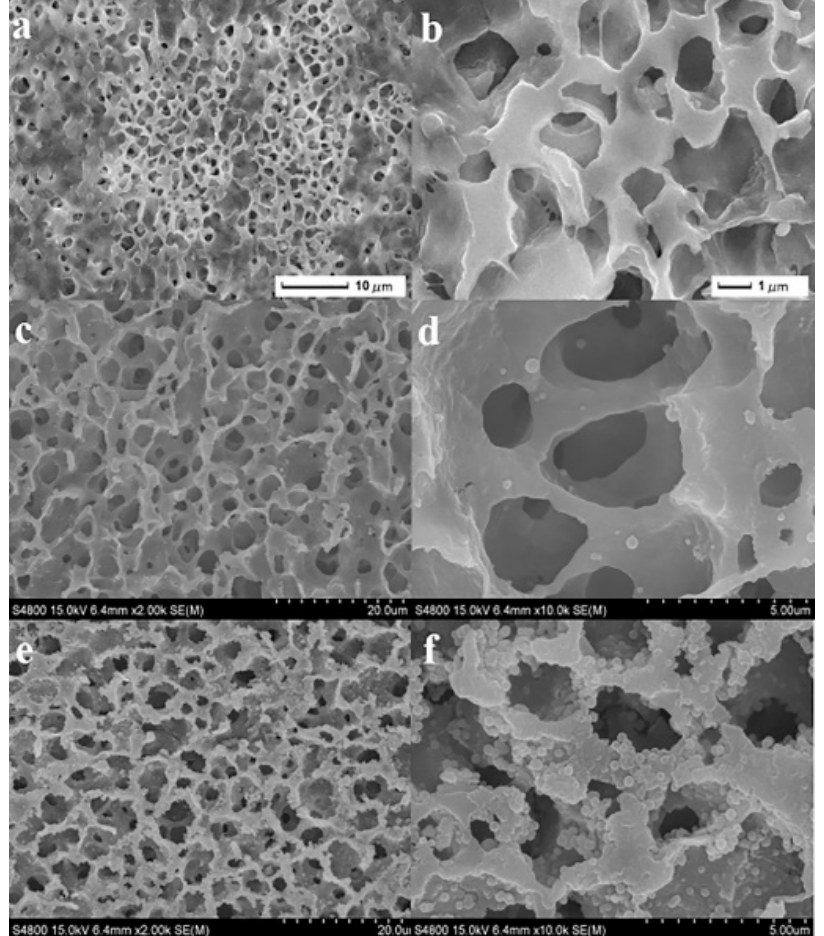
Figure 1. SEM images of ( a , b ) PVDF; ( c , d ) PVDF@pDA; and ( e , f ) PVDF@pDA@SiO 2 membranes [21].